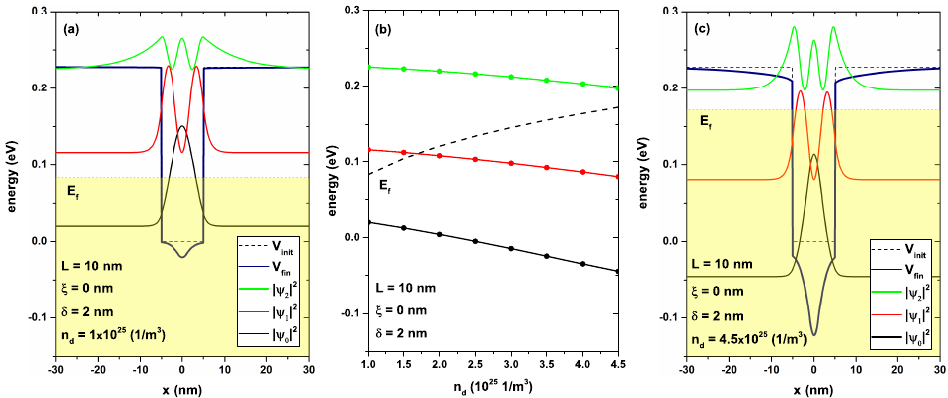
Figure 8. ( a , c ): Self-consistent potentials V ( x ) with a solid line in navy color, and electron confinement potential V c ( x ) in black dashed line. Figure ( a ) corresponds to n d = 1.0 × 10 25 (1/m 3 ) and figure ( c ) to n d = 4.5 × 10 25 (1/m 3 ). For both figures, the parameters L = 10nm, ξ = 0nm, and δ = 2nm were set. In both figures, the probability densities of some confined states were included. The shaded region indicates the occupied states, and the maximum of this region corresponded to the energy Fermi level. Figure ( b ) represents the energy of the confined states as a function of n d -parameter; the dashed line is the self-consistent Fermi level E f